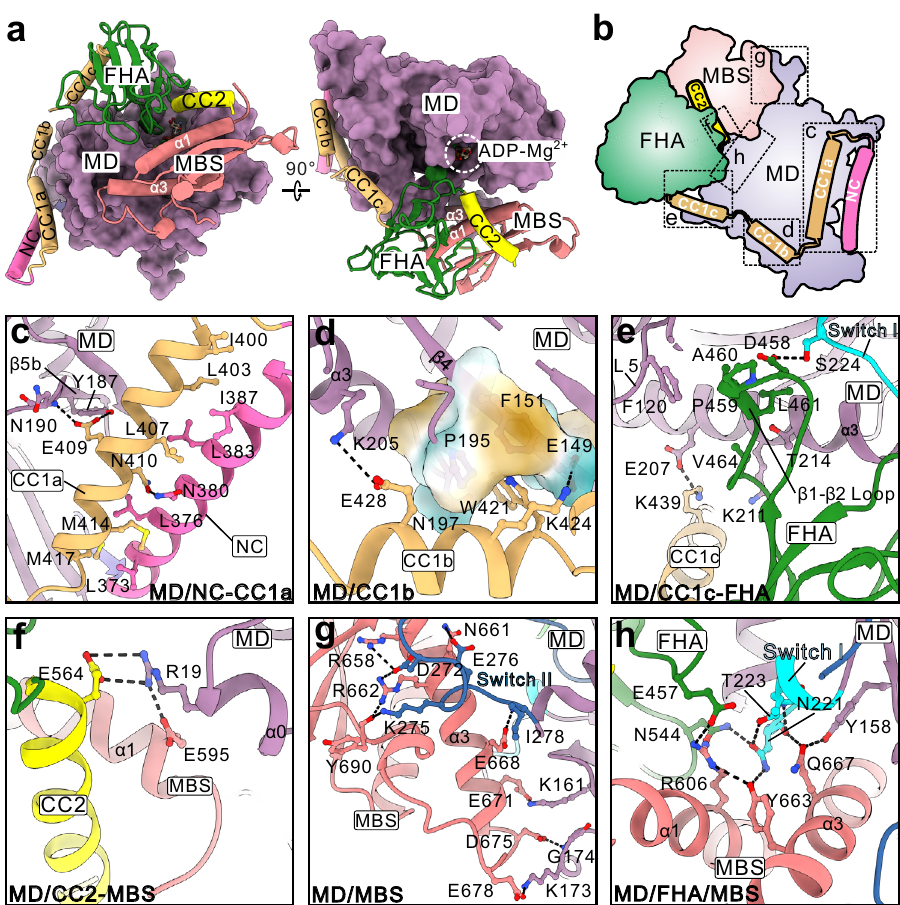
Fig. 2 | Interdomain interfaces in self-folded KLP-6. a A combined surface and ribbonrepresentationshowingtheMD-involvedinterdomaininterfaces.TheMDis in the surface representation, and the other domains are in the ribbon repre- sentation. The MATH domain is removed due to no contact with the MD. b A schematic model illustrates the MD-involved interdomain interfaces that are divi- ded into six different sites. c – h A combined ribbon-and-stick model showing the